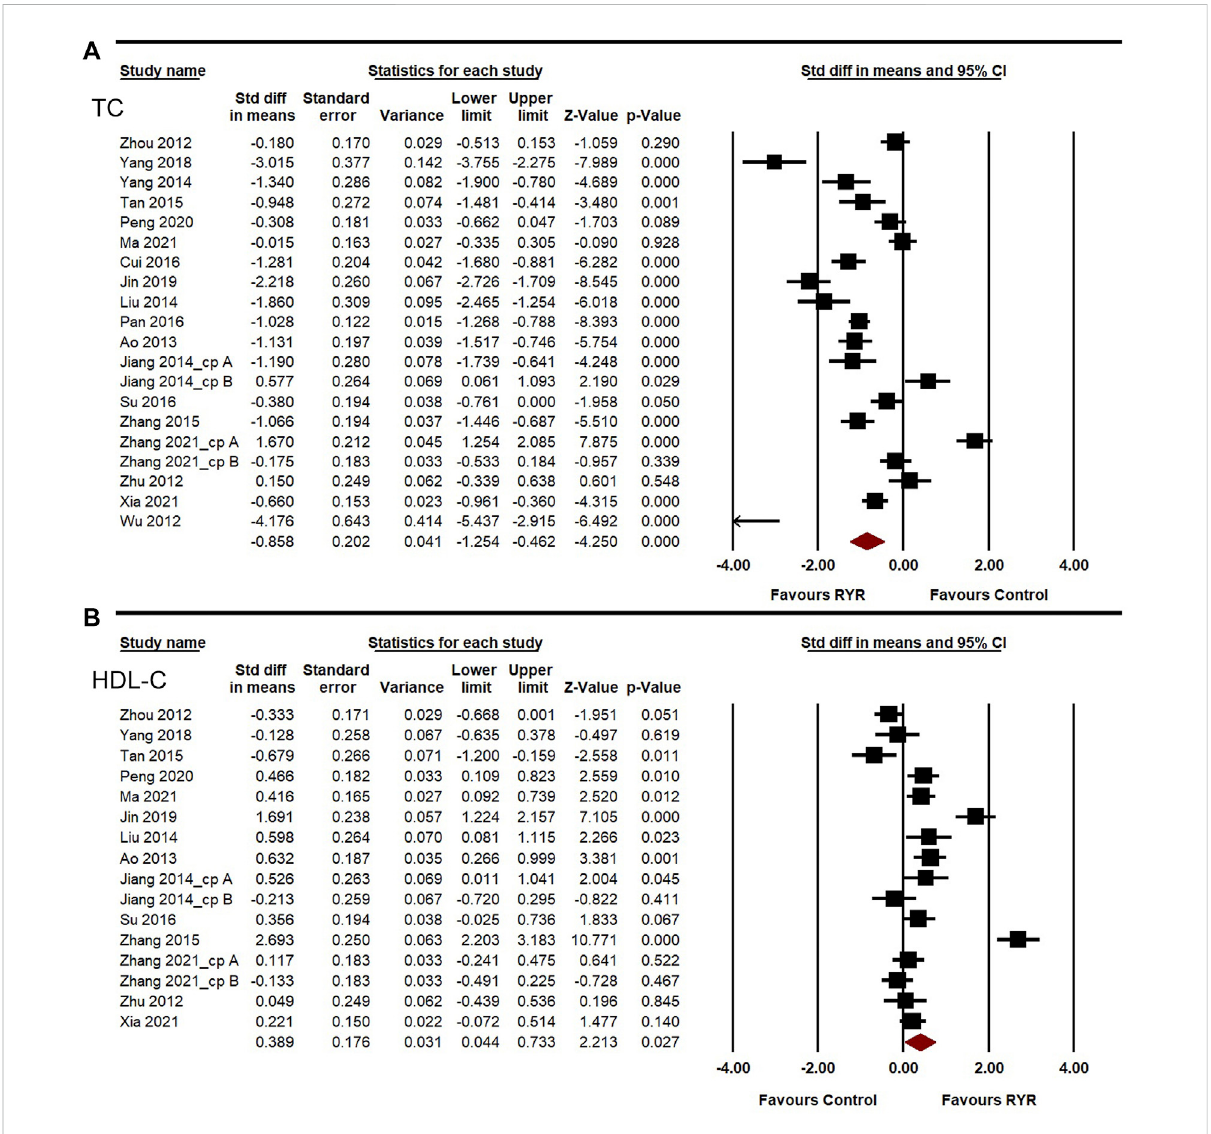
FIGURE 5 Meta-analysis of the effects of RYR therapy on TC (A) and HDL-C (B) .